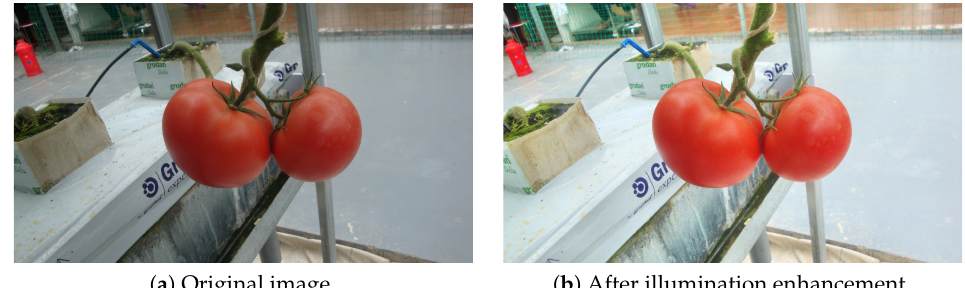
Figure 4. An example of illumination enhancement: ( a ) before enhancement and ( b ) after enhancement.